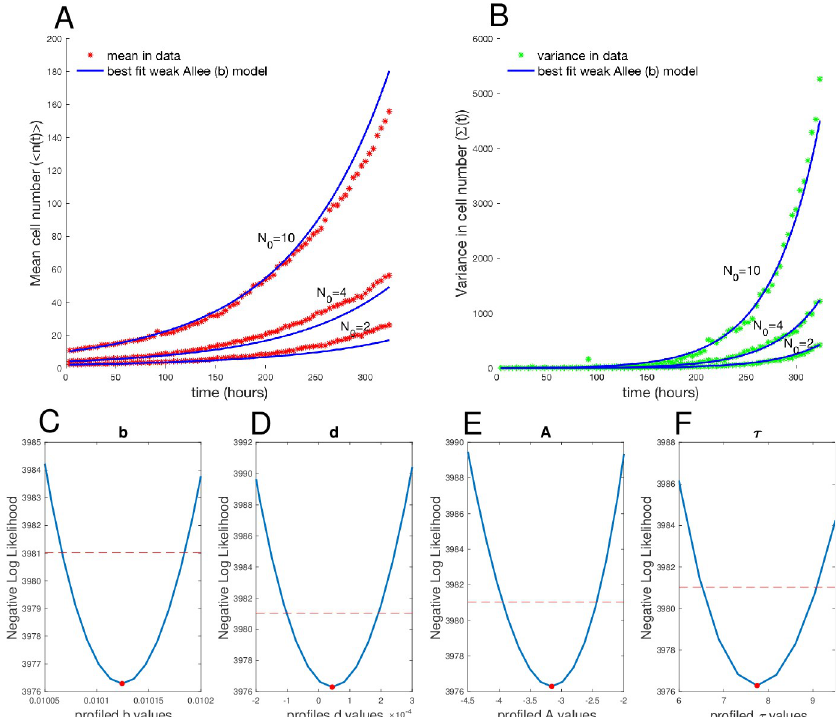
Fig 9. Mean and variance of data fit to a weak Allee model on birth. (A) Best fit of data mean to model mean displays the model fits the data well over all 3 initial conditions and over the time course. (B) Best fit of data variance to model variance displays the model fits the data well. (C) Profile likelihood analysis of birth rate around maximum likelihood b = 0.0101 [0.010068 − 0.010181]. (D) Profile likelihood analysis of death rate around maximum likelihood d = 4.3613 × 10 − 5 [ − 7.270 × 10 − 5 to 1.599 × 10 − 4 ]. (E) Profile likelihood analysis of Allee threshold A = − 3.1576 [ − 3.8593 to − 2.4559]. (F) Profile likelihood analysis of the overall shape parameter τ = 7.480 [6.8871 − 9.0393]. The data and code used to generate this figure can be found at https://github.com/brocklab/Johnson-AlleeGrowthModel.git.